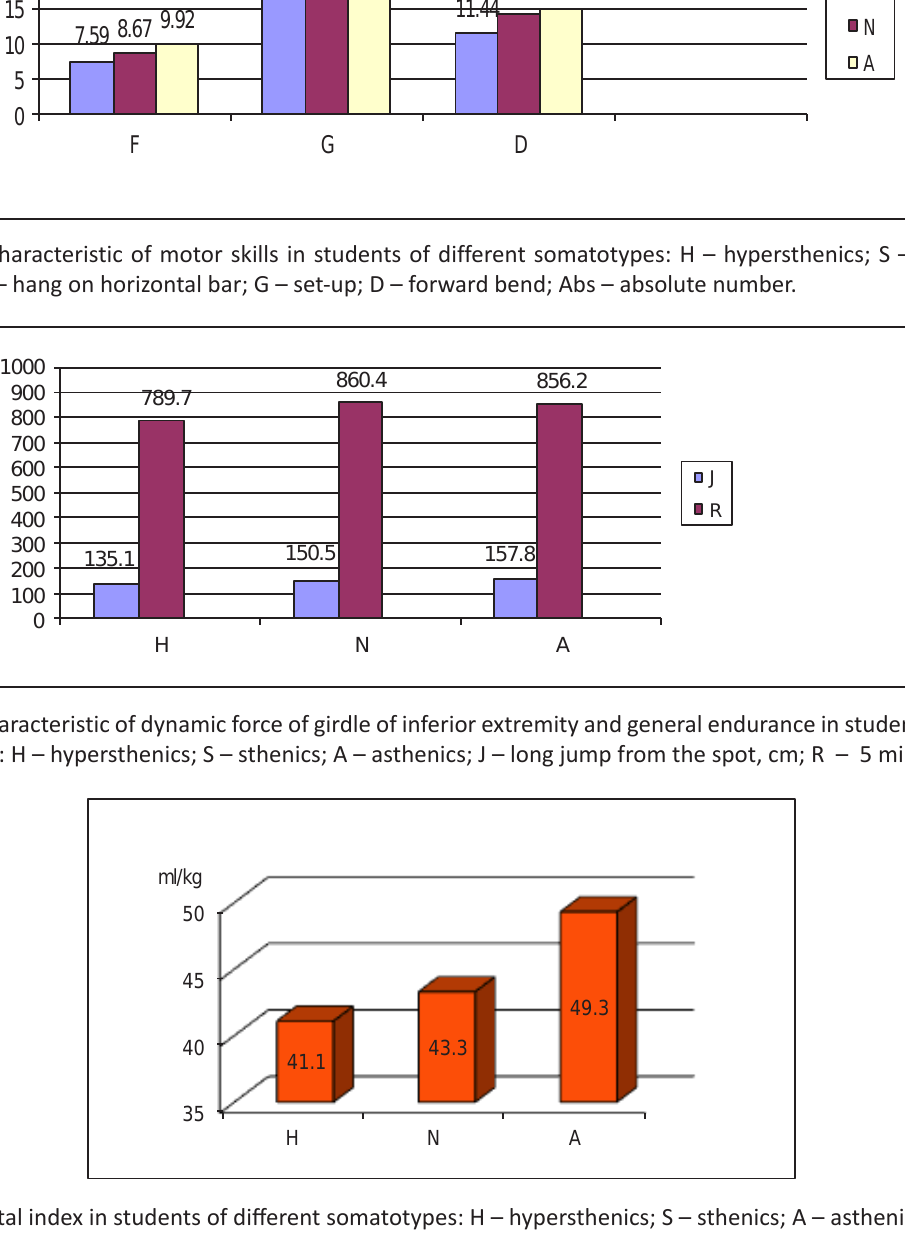
Fig. 3. The vital index in students of different somatotypes: H – hypersthenics; S – sthenics; A –